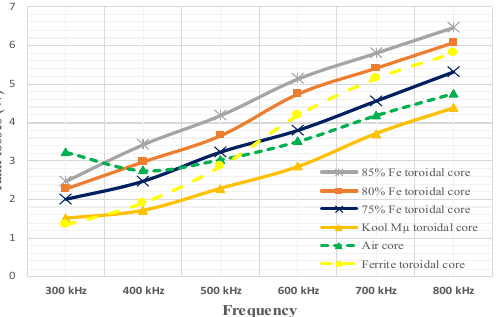
Figure 23. Power losses in the resonant tank at different switching frequencies.